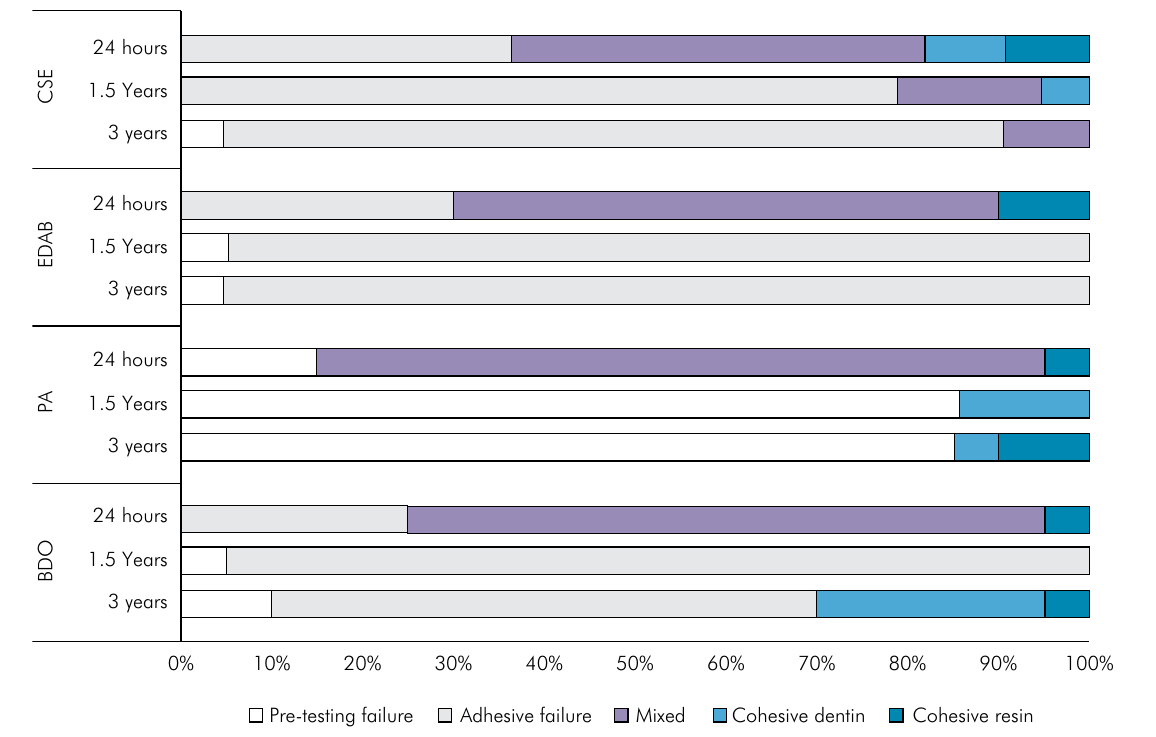
Figure 2. Distribution of failure modes for all groups (mixed failure, adhesive failure, cohesive resin, cohesive dentin).